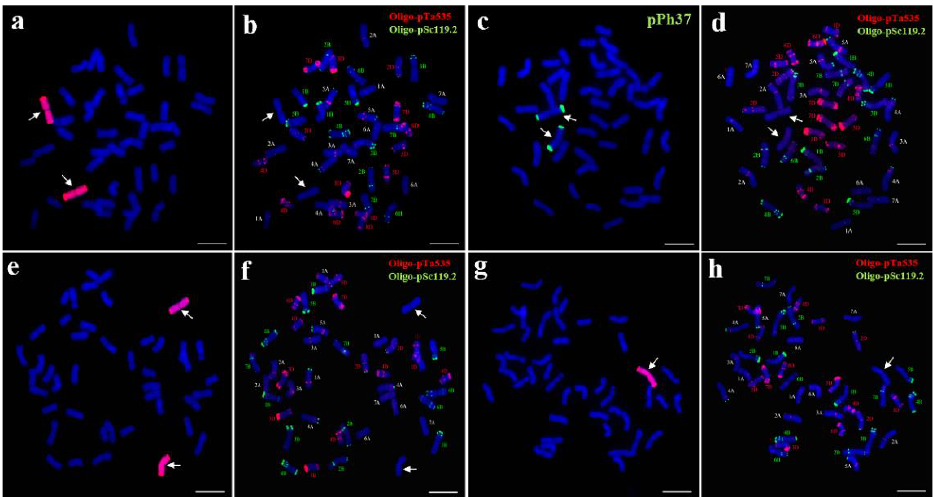
Figure 1. Sequential GISH and mc-FISH analysis of the wheat – P. huashanica disomic addition line 18-1-5. ( a , e , g ) GISH detection of 18-1-5 using P. huashanica genomic DNA as a probe (red). ( b , d , f , h ) mc-FISH analysis of 18-1-5 using Oligo-pSc119.2 (green) and Oligo-pTa535 (red). ( c ) FISH identification of 18-1-5 using pPh37 (green). Arrows indicate the introduced P. huashanica chromosomes in line 18-1-5. Scale bar: 10 μm.